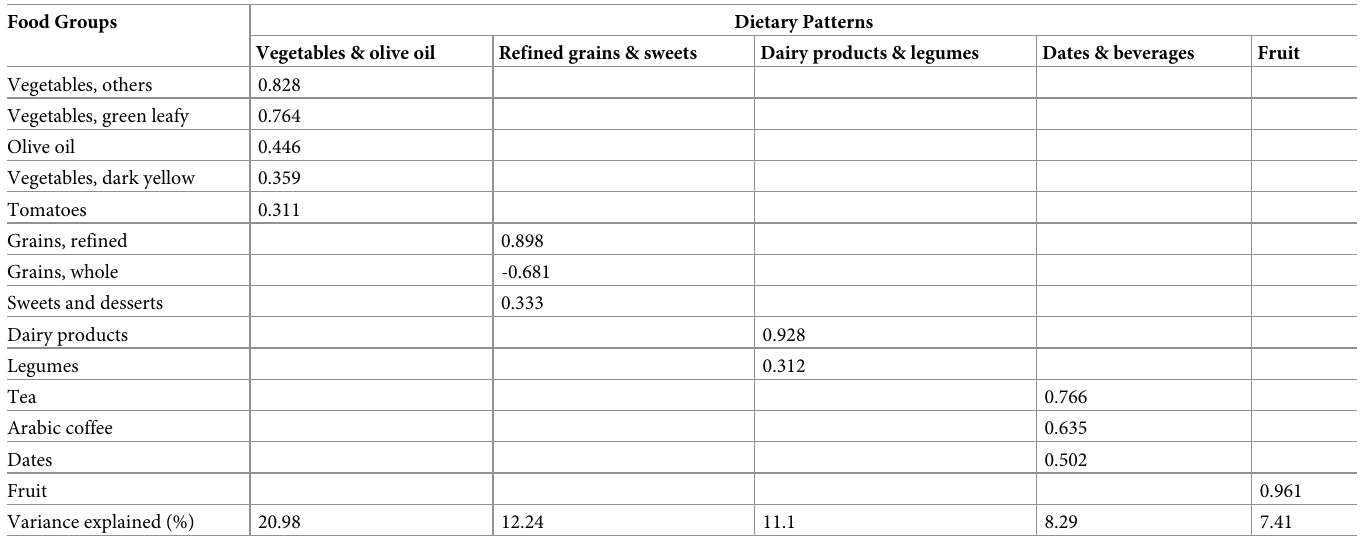
Table 3. Factor loads for diet patterns a,b